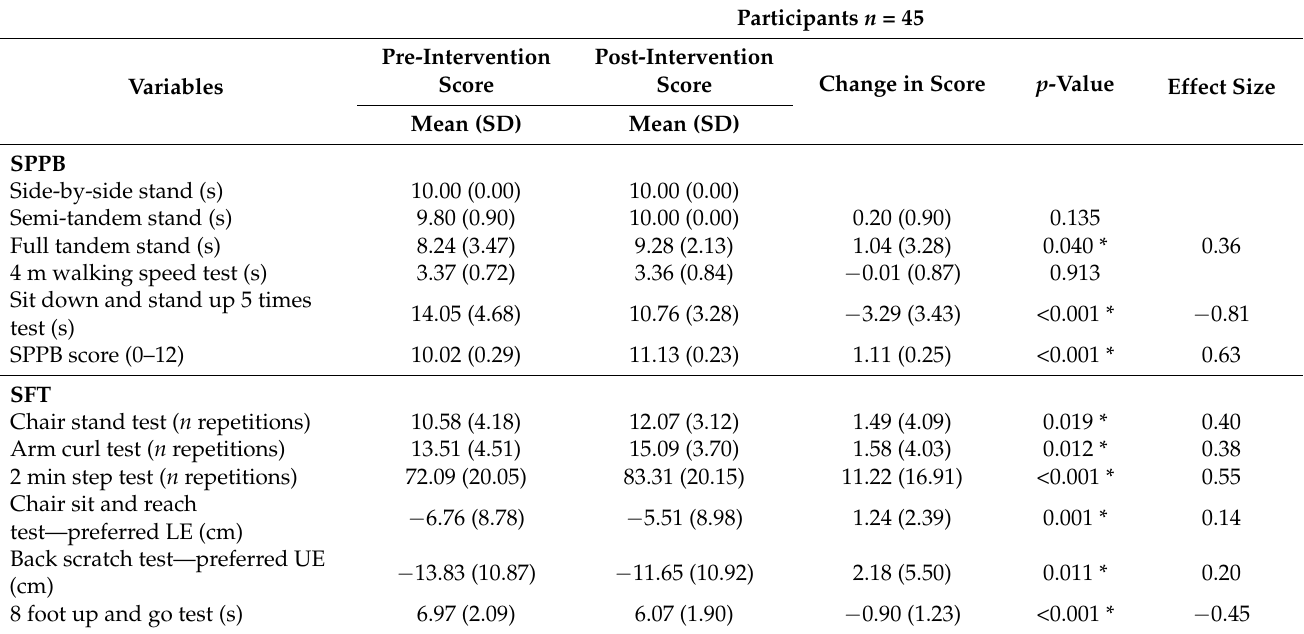
Table 4. Pre–post intervention comparison of physical–functional condition variables among partici- pants of a structured multicomponent physical exercise